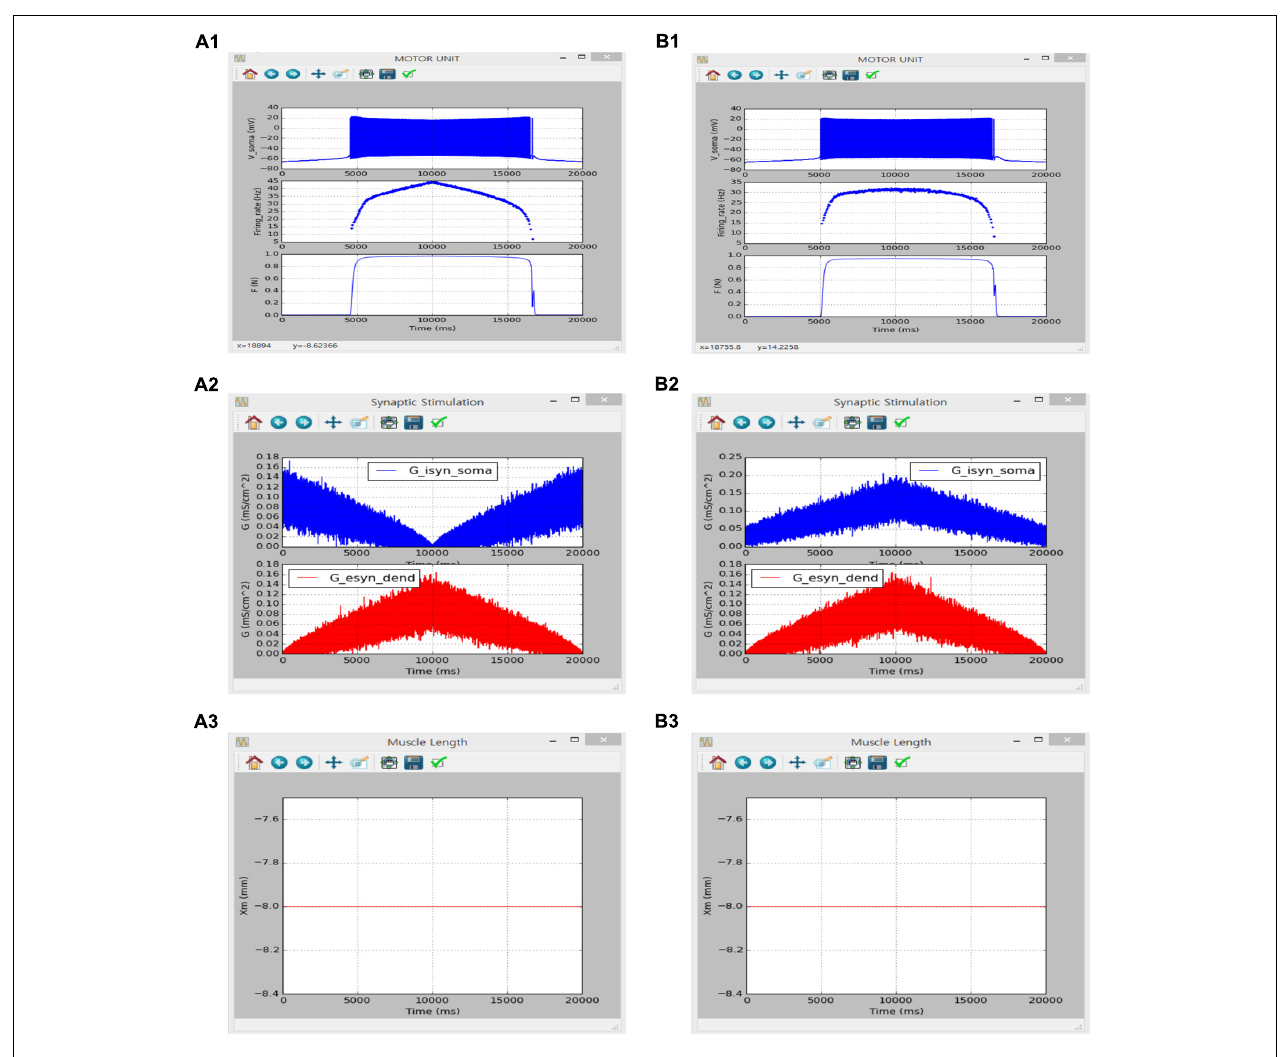
FIGURE 10 | Non-linear input-output behavior of a slow motor unit with G isyn , soma and G esyn , dend including intensity-dependent synaptic noise. (A1–A3) Voltage responses at the soma (V soma , upper panel in A1 ), instantaneous firing rate (Firing_rate, middle panel in A1 ) and muscle force (F, bottom panel in A1 ) against triangular variation in inhibitory synaptic input at the soma (G isyn , soma , blue lines in A2 ) and excitatory synaptic input at the dendrite (G esyn , dend , red lines in A2 ) in a push-pull manner at the optimal muscle length (X m , A3 ). (B1–B3) Voltage responses at the soma (V soma , upper panel in B1 ), instantaneous firing rate (Firing_rate, middle panel in B1 ) and muscle force (F, bottom panel in B1 ) against triangular variation in inhibitory synaptic input at the soma (G isyn , soma , blue lines in B2 ) and excitatory synaptic input at the dendrite (G esyn , dend , red lines in B2 ) in a proportional manner while maintaining the optimal muscle length (X m , B3